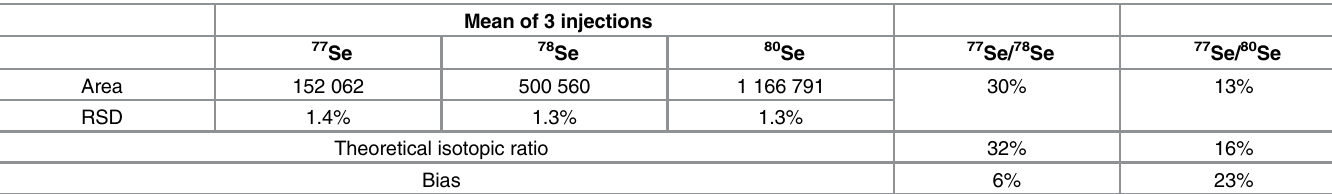
Table 1. Isotopic ratios measured with the isocratic elution at 50% of